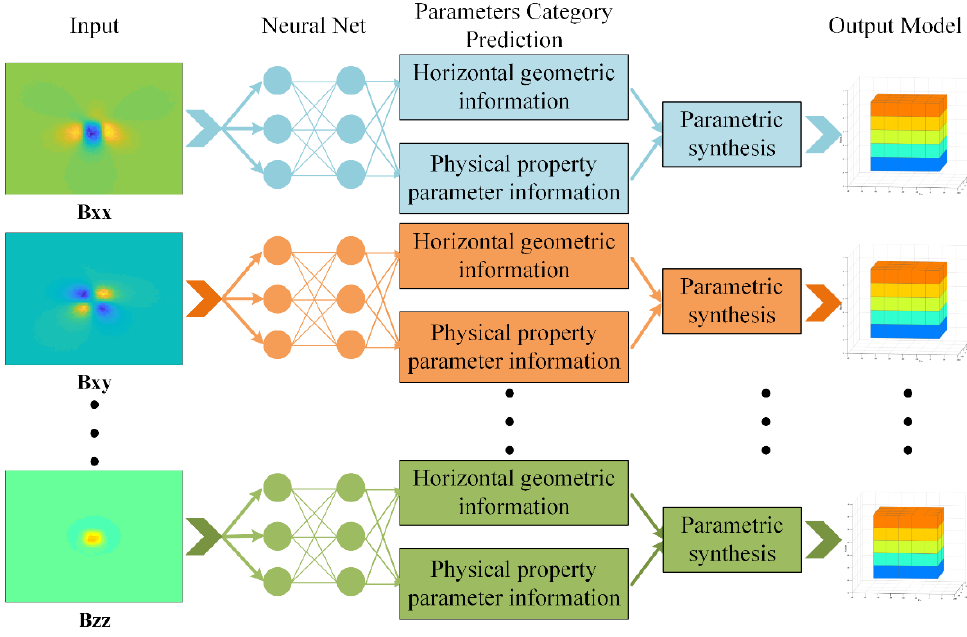
Figure 3. Schematic diagram of the MGT CNN inversion process.